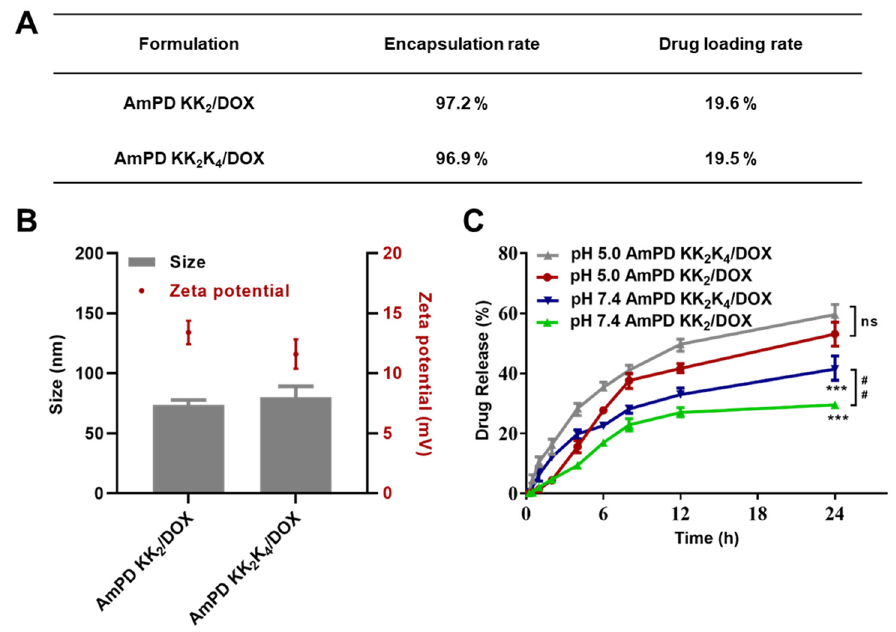
Figure 2. Physicochemical properties of the AmPDs/DOX nanoformulations. ( A ) Encapsulation efficiency and drug loading content of the AmPDs/DOX nanoformulations. ( B ) Size and Zeta potential of the AmPDs/DOX nanoformulations (mean ± SD, n = 3). ( C ) The release of DOX from AmPDs/DOX nanoformulations at different pH values (5.0 and 7.4) (mean ± SD, n = 3, ## p < 0.01 represented AmPD KK 2 /DOX at pH 7.4 vs. AmPD KK 2 K 4 /DOX at pH 7.4, *** p < 0.001 represented AmPDs/DOX at pH 7.4 vs. AmPDs/DOX at pH 5.0, ns represented not statistically significant).